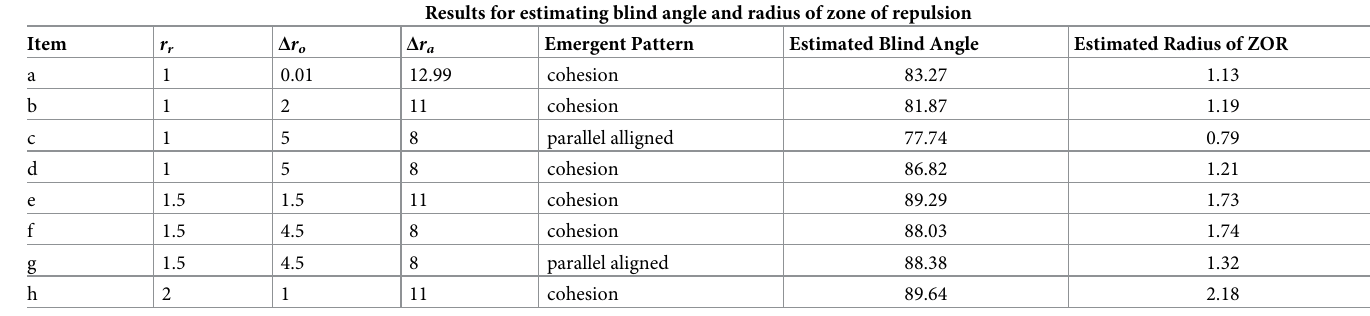
The individuals all had a blind angle of ω